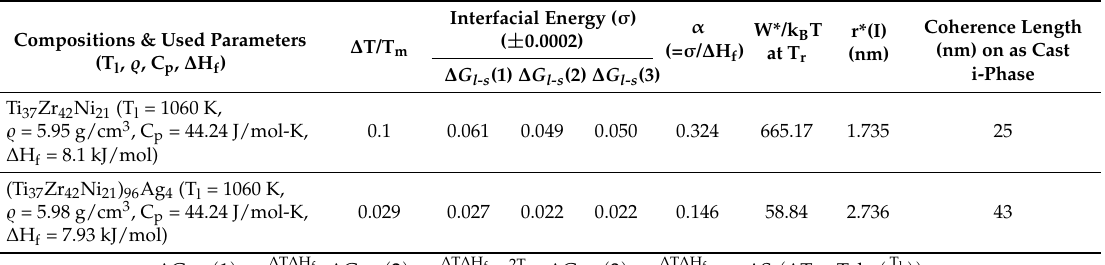
Table 1. A degree of supercooling, interfacial free energy, Turnbull coefficient, nucleation